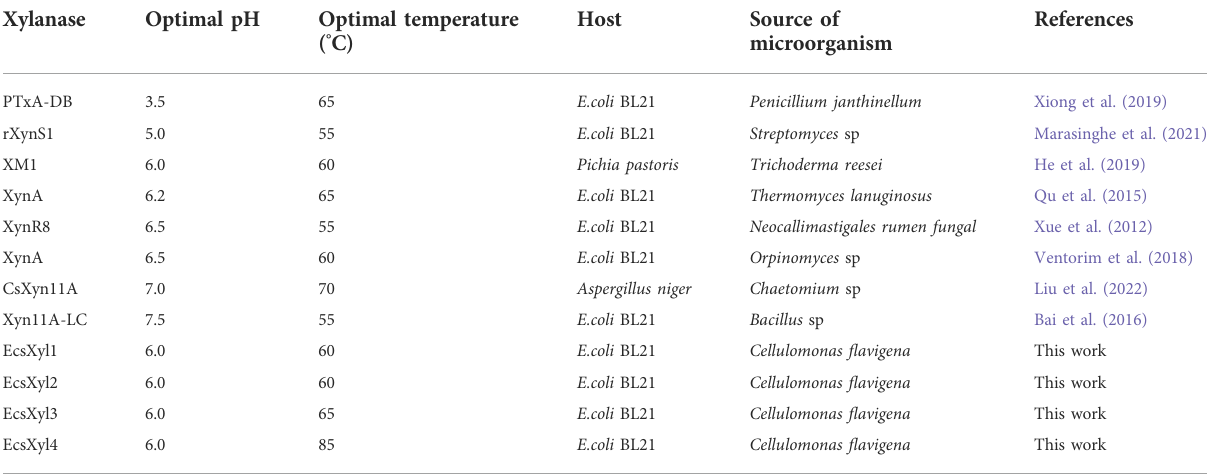
TABLE 1 Comparison of properties of other reported